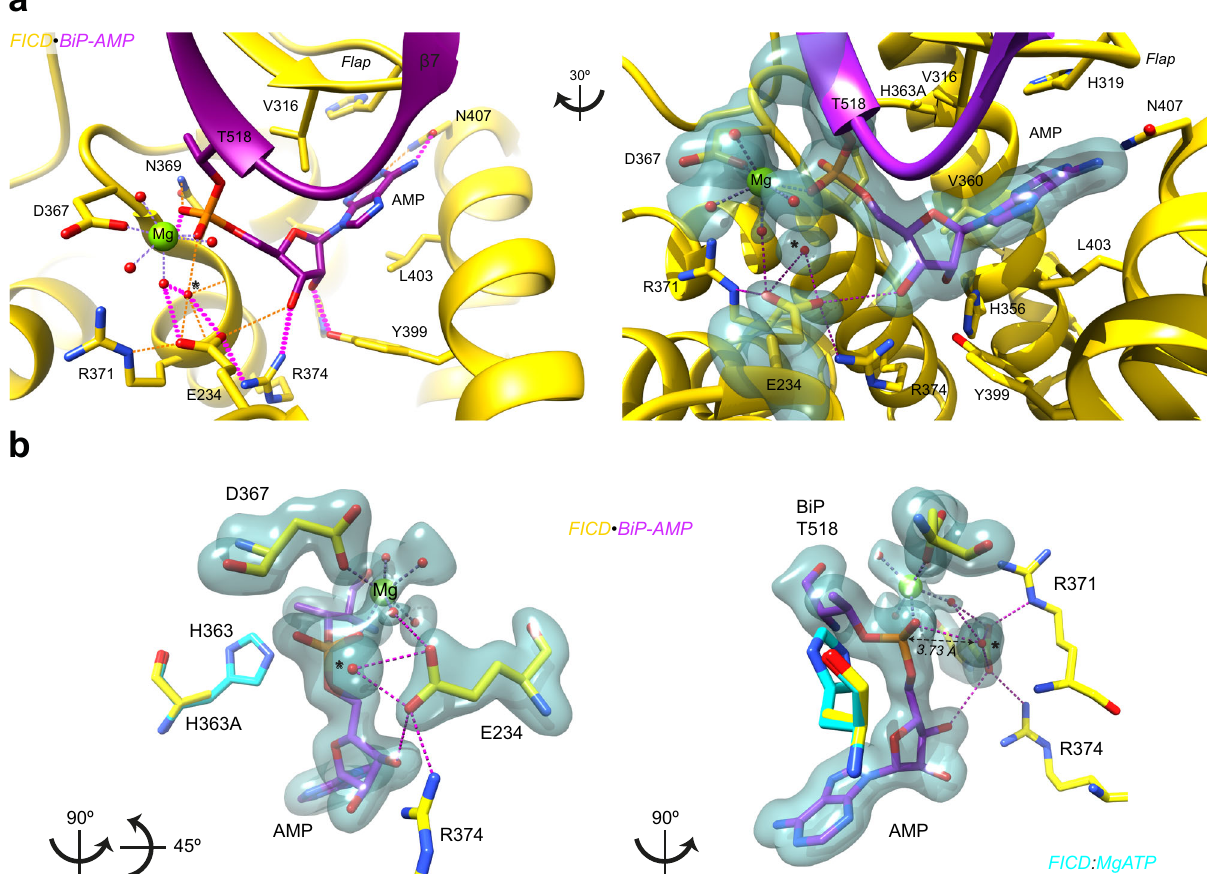
Fig. 6 The enzymatic mechanism of eukaryotic deAMPylation. a BiP ’ s Thr518-AMP (purple) bound to FICD (yellow). Left, the arrangement of BiP ’ s AMPylated Thr518 and Mg 2 + cation within the Fic domain active site. Residues interacting with Mg 2 + and the AMP moiety are shown as sticks and annotated. Hydrogen-bonds involving the AMP moiety and FICD ’ s Glu234 sidechain are shown (with high con fi dence hydrogen bonds depicted with thick, pink dashed lines and those only meeting relaxed hydrogen bond constraints depicted with orange dashed lines). Note, the putative catalytic water molecule* forms hydrogen bonds to Glu234 (located at the top of α inh ) and potential hydrogen bonds to the backbone NH groups of the Fic domain anion- binding nest (G 368 NG 370 ) and Arg371 (see Supplementary Fig. 8). Right, a slightly rotated view of the FICD-active site, shown on the left, overlaid with an unbiased polder OMIT electron density map, contoured at 4 σ . For clarity only hydrogen bonds formed by Glu234 are shown (pink dashed lines). b As in the right-hand side of a but reduced to highlight Glu234 ’ s coordination of the catalytic water molecule* and its position in-line for nucleophilic attack into the α - phosphate. Additionally, the putative general acid, His363, is modelled based on an alignment of FICD:MgATP (PDB 6I7K, turquoise) 19 . See Supplementary Movie